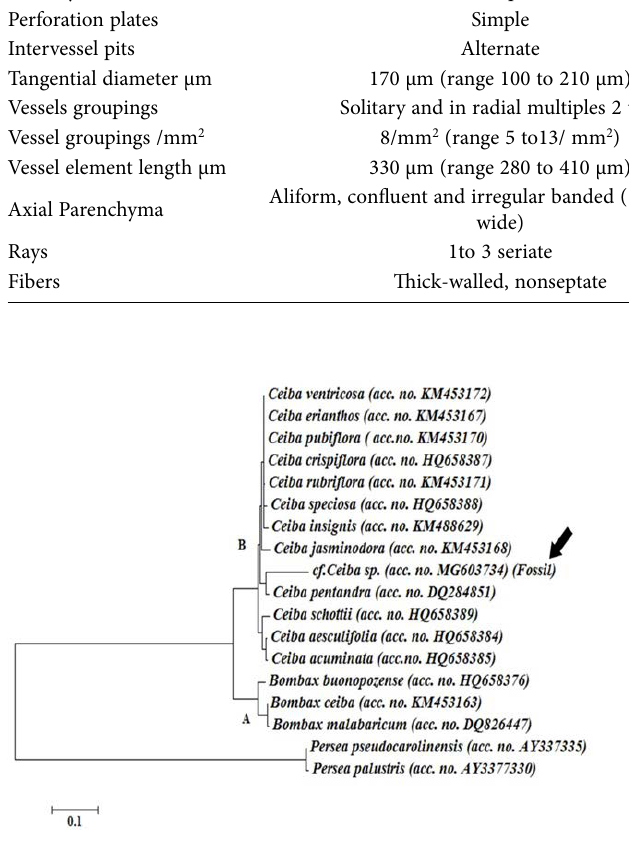
Fig. 3. Maxim- Likelihood (ML) cladogram showing the relation- ships of the ITS gene from cf. Ceiba sp. in relation to its relatives. All analyses were performed with 1000 bootstrap replicates (arrow: fossil specimens, acc. no.: accession number).